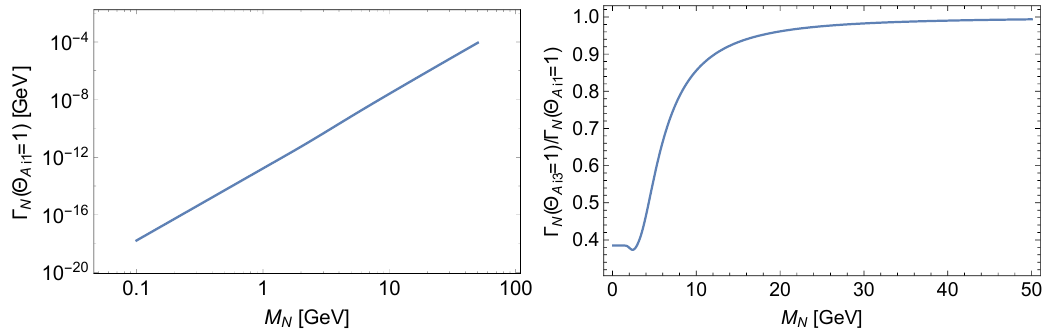
into Standard Model states assuming i